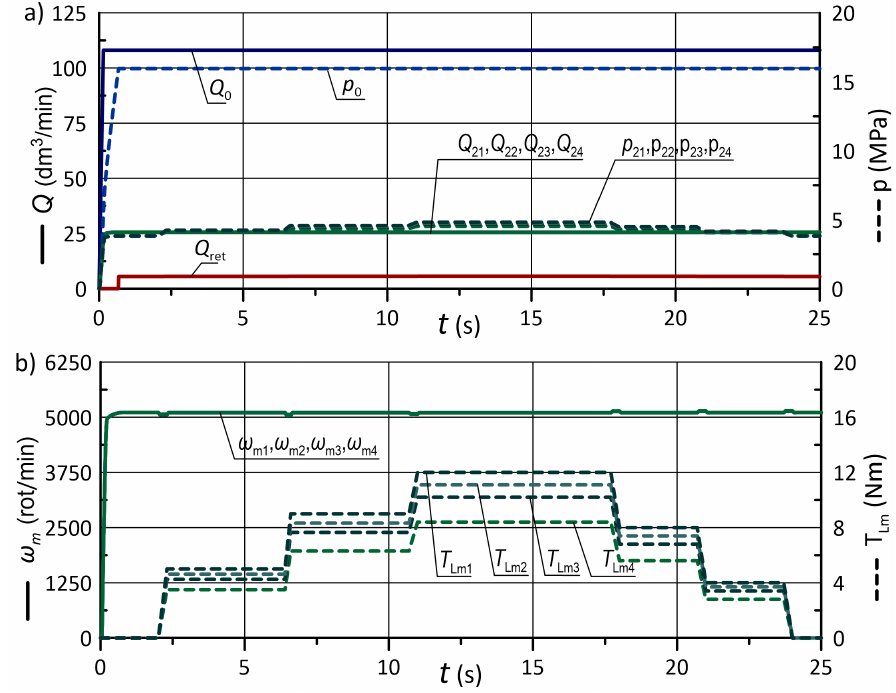
Figure 15. Operating cycle in a low load range, T Lm , max = 12 N m, with load variation of particular motors by 30%; ( a ) flow rates and pressures; ( b ) rotational speed of hydraulic motors and load